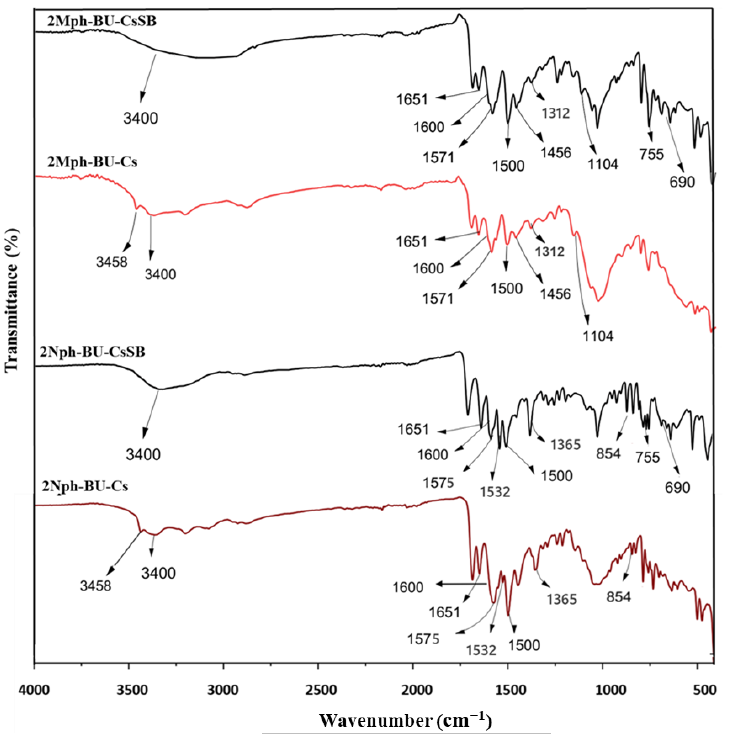
Figure 2. FTIR spectra of 2Mph-BU-CsSB, 2Mph-BU-Cs, 2Nph-BU-CsSB and 2Nph-BU-Cs hydro- gels.